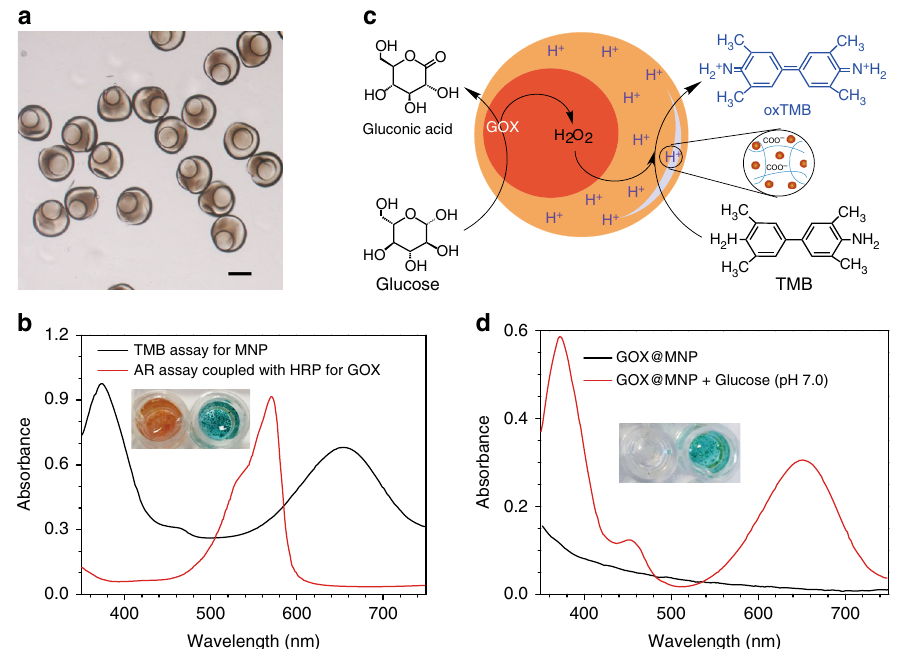
Fig. 5 GOX@MNP functions as an integrated tandem catalytic system. a Microscopic image of GOX@MNP. Scale bar: 200 μ m. b Absorption spectra of oxTMB ( black line ) and resoru fi n ( red line ) produced from the GOX@MNP-catalyzed TMB-H 2 O 2 assay and glucose-triggered Amplex Red assay in the presence of GOX@MNP and HRP, respectively; both were performed in PBS (pH 7.0, 10 mM). Inset : corresponding visual colors of these two samples. c Schematic illustration of the glucose-triggered TMB oxidation reaction in the presence of GOX@MNP. d Absorption spectra and visual color changes of oxTMB obtained from the TMB oxidation reaction catalyzed by GOX@MNP in the absence ( black line ) and presence ( red line ) of glucose in PBS (pH 7.0, 10